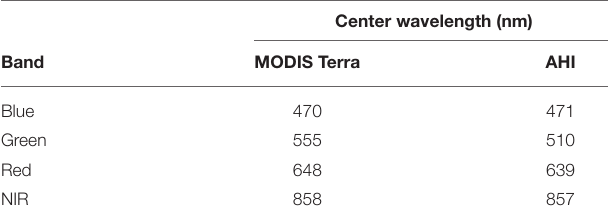
TABLE 1 | Summary of target SR bands: MODIS Terra Level 1B and AHI-12 SR